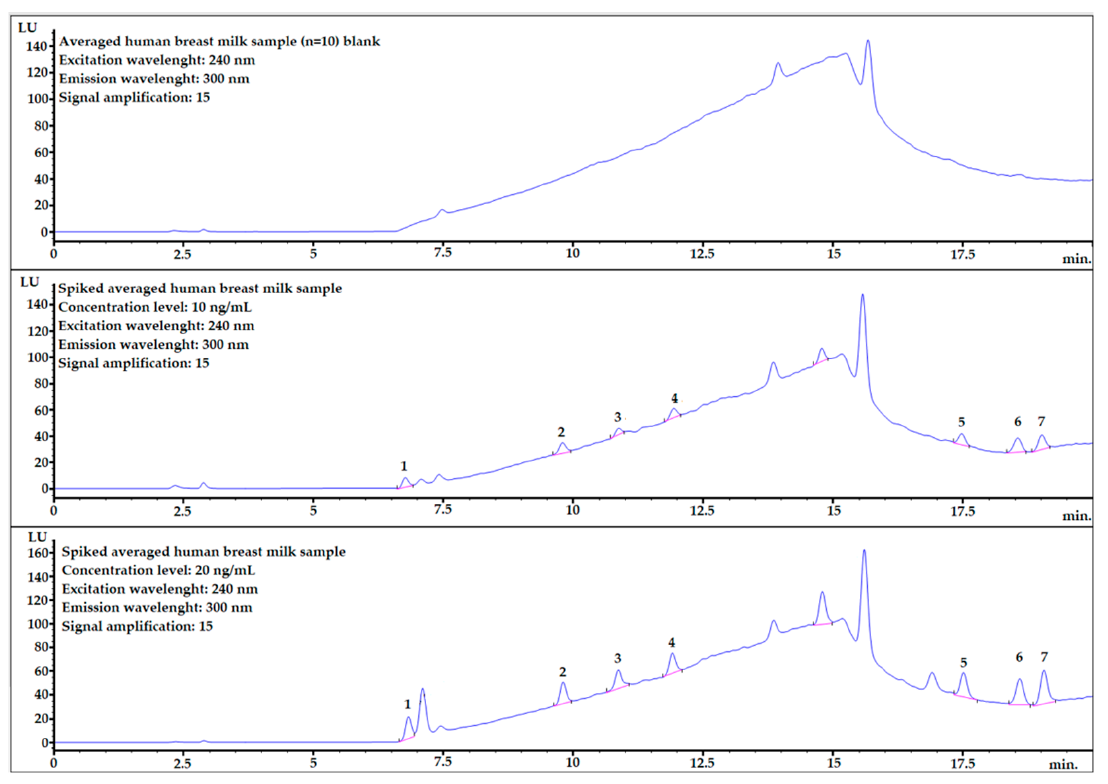
Figure 5. Example chromatograms of averaged human breast milk sample blank ( top ), and spiked samples at two different concentration levels: 10 ng/mL ( middle ) and 20 ng/mL ( bottom ). 1—